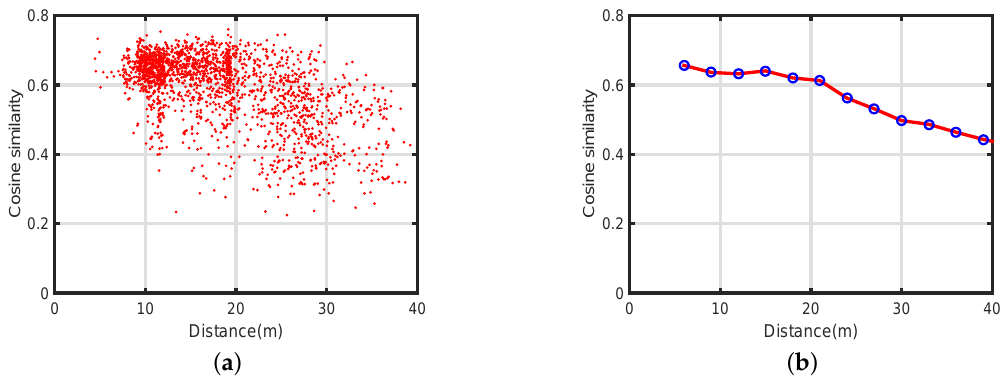
Figure 8. Relationship between pedestrian distance and cosine similarity. ( a ) Relationship between distance and similarity for each sample. ( b ) Statistical curve of relationship between quantized distance and average